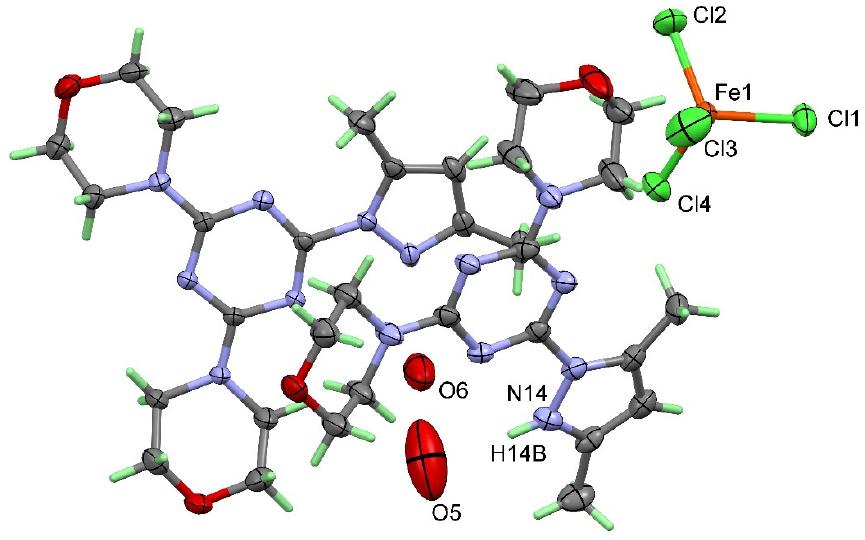
Figure 5. X-ray structure of compound 3 . All atoms have been drawn at a 50% probability level.